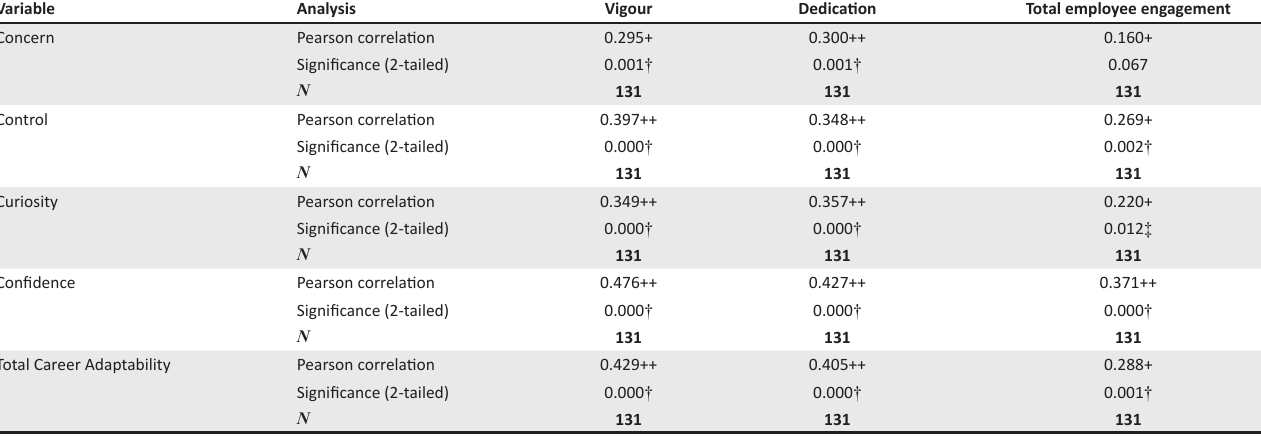
TABLE 3: Pearson’s product–moment correlations: Career Adapt-Abilities Scale and Utrecht Work Engagement Scale.